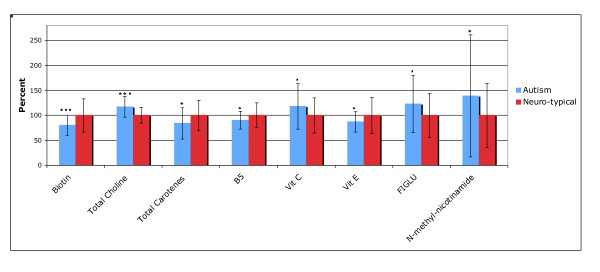
Vitamins and related substances which were significantly different between the autism and neurotypical groups, rescaled to the average neurotypical values. The average values and the standard deviations are shown. The number of asterisks indicates the p-value (* p < 0.05, ** p < 0.01, *** p < 0.001).